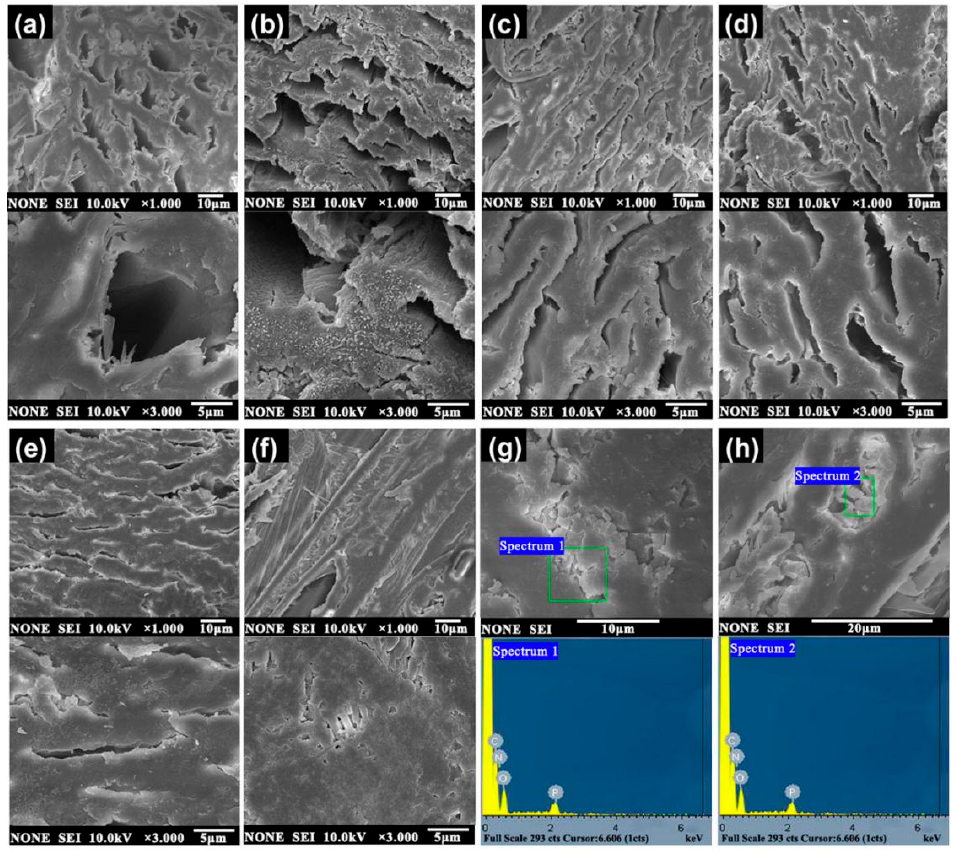
Figure 6. Scanning electron microscopy (SEM) micrographs of treated samples: ( a ) Wc; ( b ) W NP ; ( c ) W TM ; ( d ) W HT-TM ; ( e ) W NP-TM on transverse section; ( f ) W NP-TM on tangential section; ( g , h ) energy-dispersive X-ray analysis (EDXA) spectra of W NP-TM